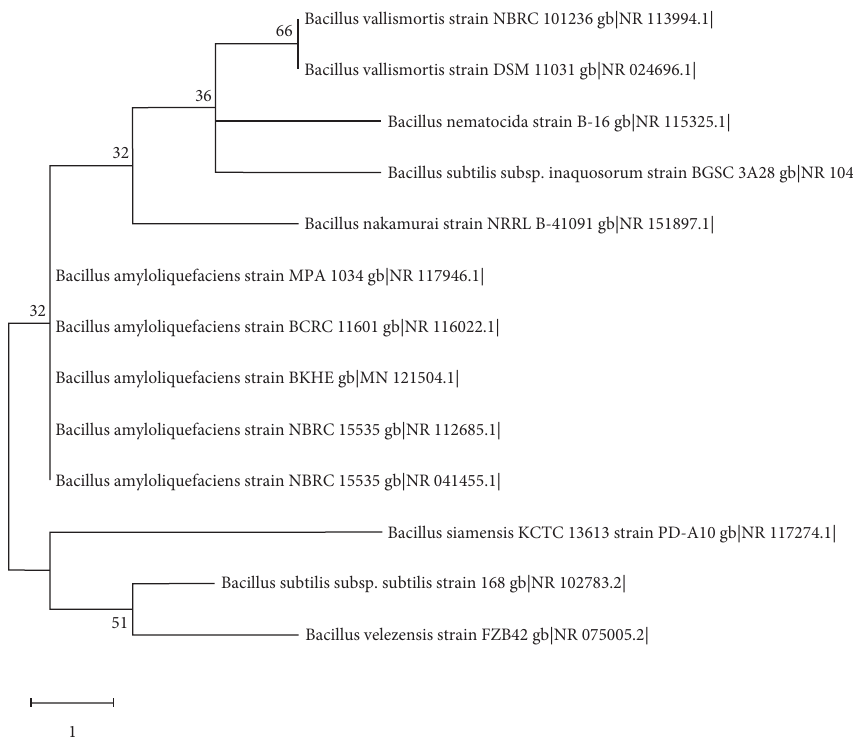
Figure 5: Maximum parsimony tree generated from 16S rRNA sequence data. Branches corresponding to partitions reproduced in less than 50% of bootstrap replicates are collapsed. Te percentage of replicate trees in which the associated taxa clustered together in the bootstrap test is shown next to